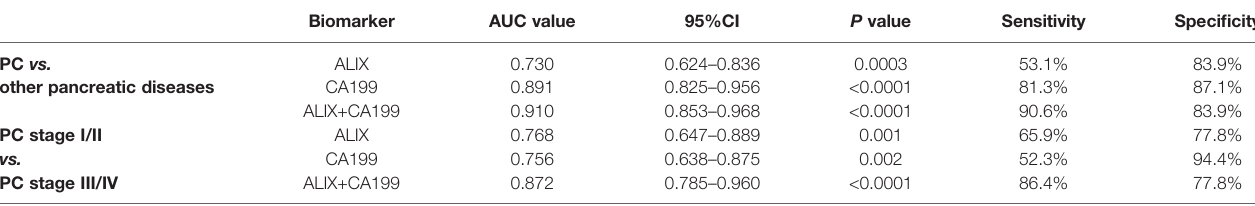
TABLE 3 | Diagnostic performance of exosomal ALIX and serum CA199 in distinguishing PC vs. patients with other pancreatic diseases and PC patients at different stages.